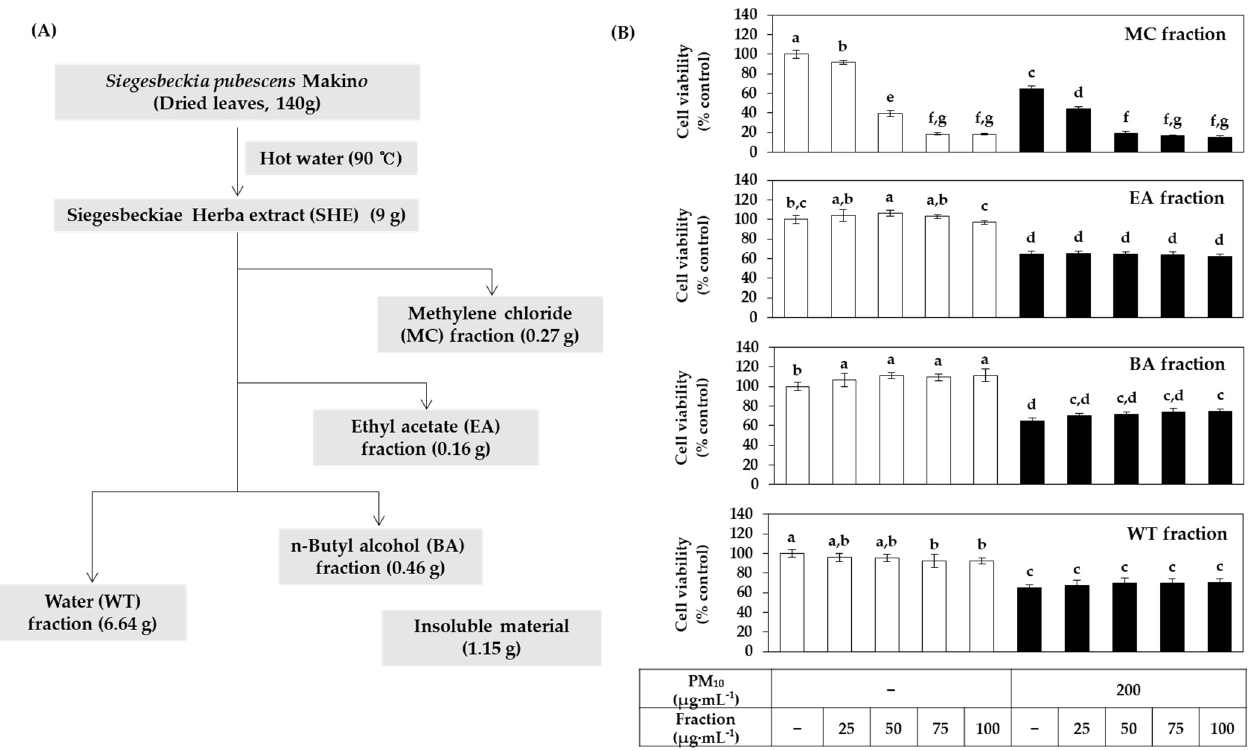
Figure 8. Effects of various solvent fractions of SHE on the viability in HaCaT keratinocytes exposed to PM 10 . ( A ) SHE was separated into methylene chloride (MC), ethyl acetate (EA), n-butyl alcohol (BA), and water (WT) fractions. ( B ) Cells were treated with each solvent fraction at different concentrations and cultured in the absence or presence of PM 10 (200 μ g mL − 1 ) for 48 h. Cell viability was determined by the MTT assay. Data are presented as mean ± SD ( n = 4). Duncan’s multiple range test was performed to compare all group means to each other. Groups that share the same letters (a–g) do not have significantly different means at the p < 0.05 level.